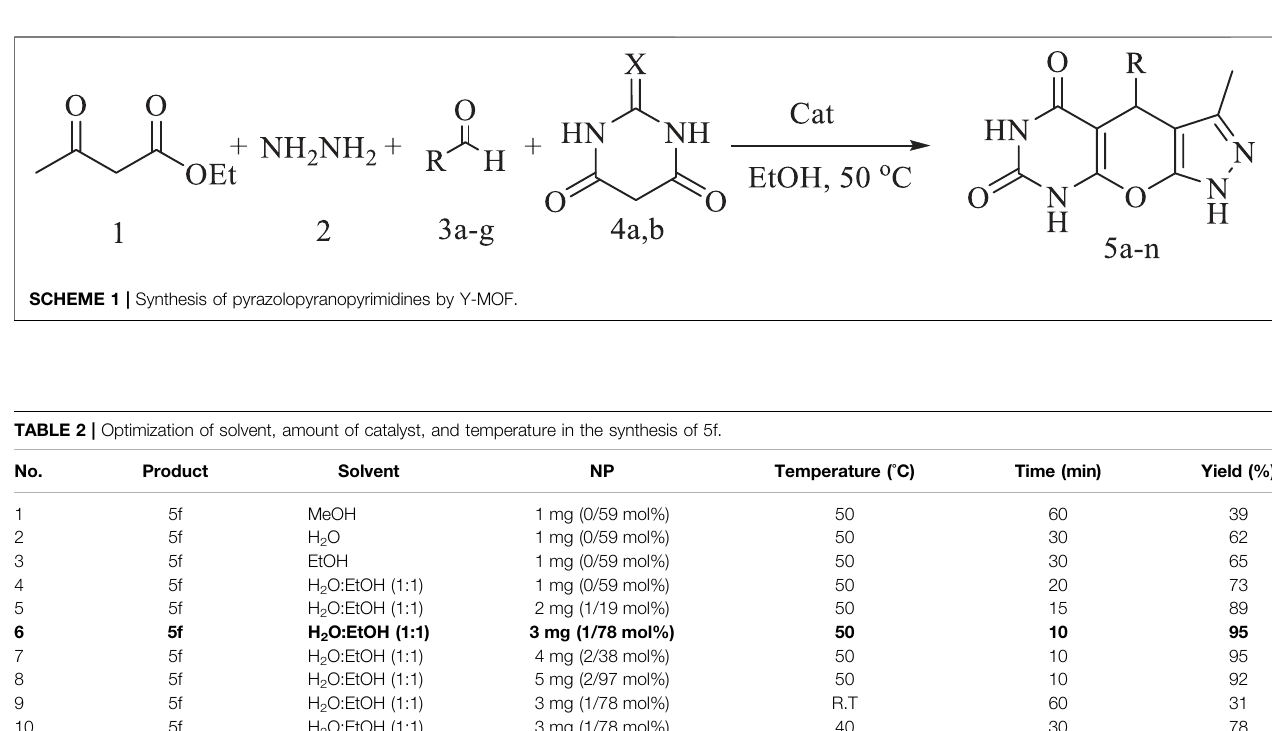
The optimal conditions for obtaining 5f were H 2 O:EtOH (1:1) as a solvent, using 3 mg (1/78 mol%) of catalyst and a temperature of 50 ° C.